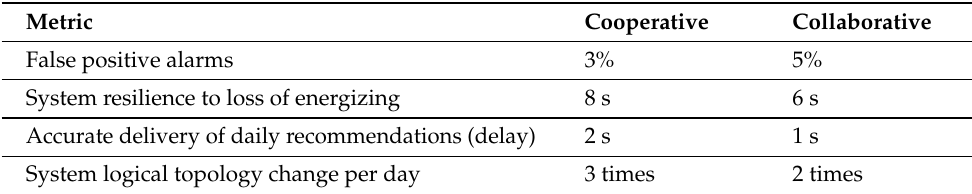
Table 3. System performance metrics towards the